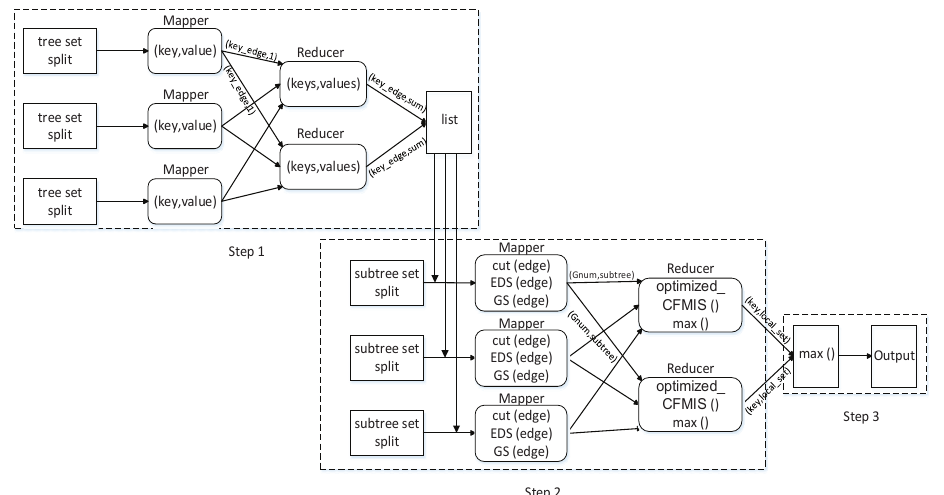
Figure 3. Parallel algorithm PCFMIS3 flowchart.